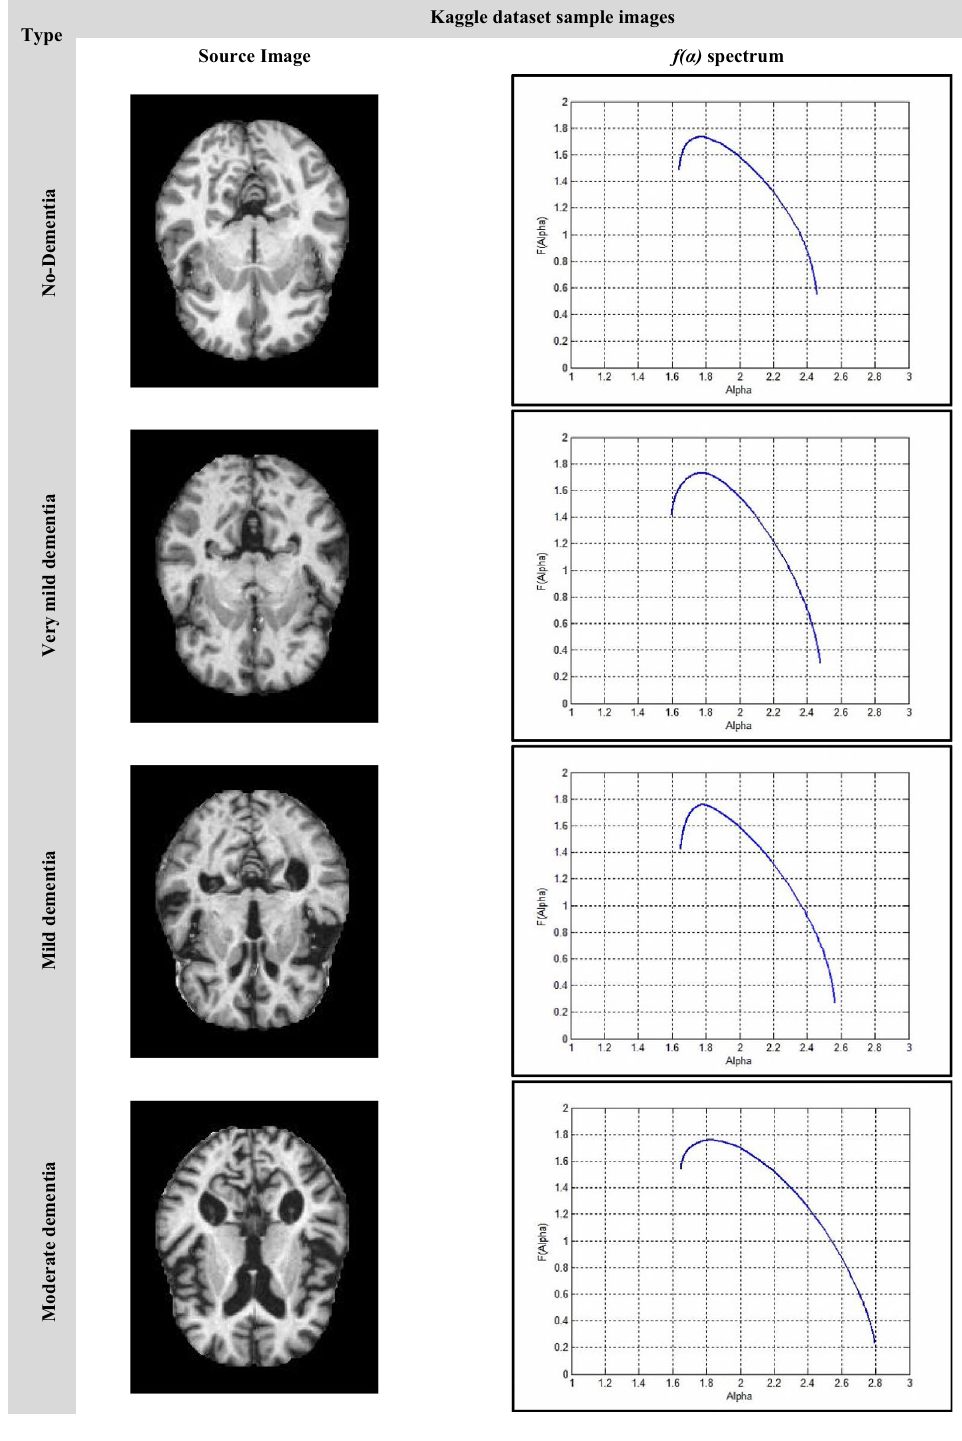
Figure 9. The Kaggle dataset sample